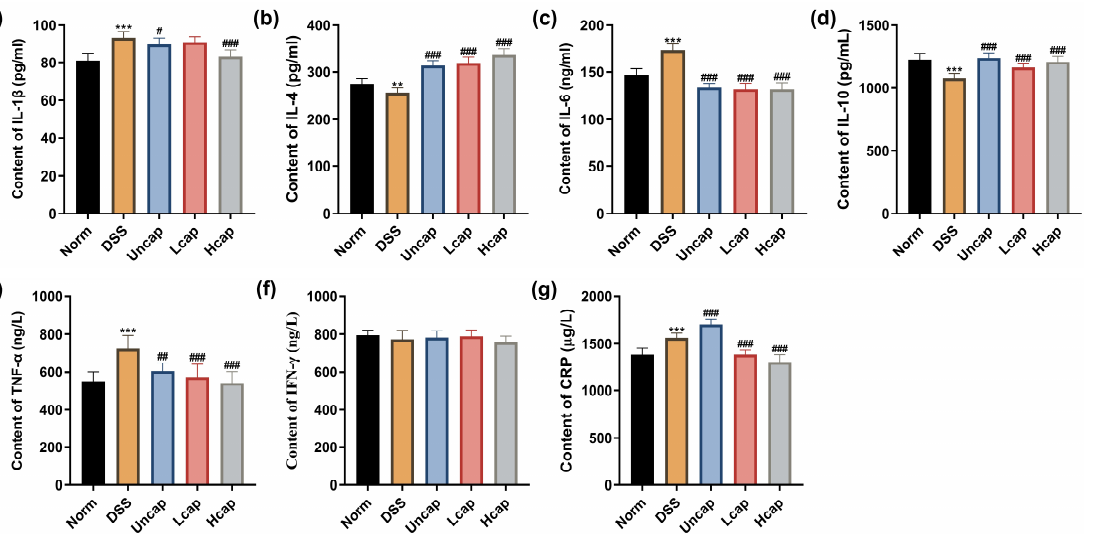
Figure 4. S. spongiosa polysaccharides alleviated inflammatory response in colitis mice. The concen- tration of IL-1 β ( a ), IL-4 ( b ), IL-6 ( c ), IL-10 ( d ), TNF- α ( e ), IFN- γ ( f ) and CRP ( g ) were estimated by ELISA. The values are reported as means ± SD ( n = 8). ** p < 0.01 and *** p < 0.001 vs. Norm group; # p < 0.05, ## p < 0.01 and ### p < 0.001 vs. DSS group.